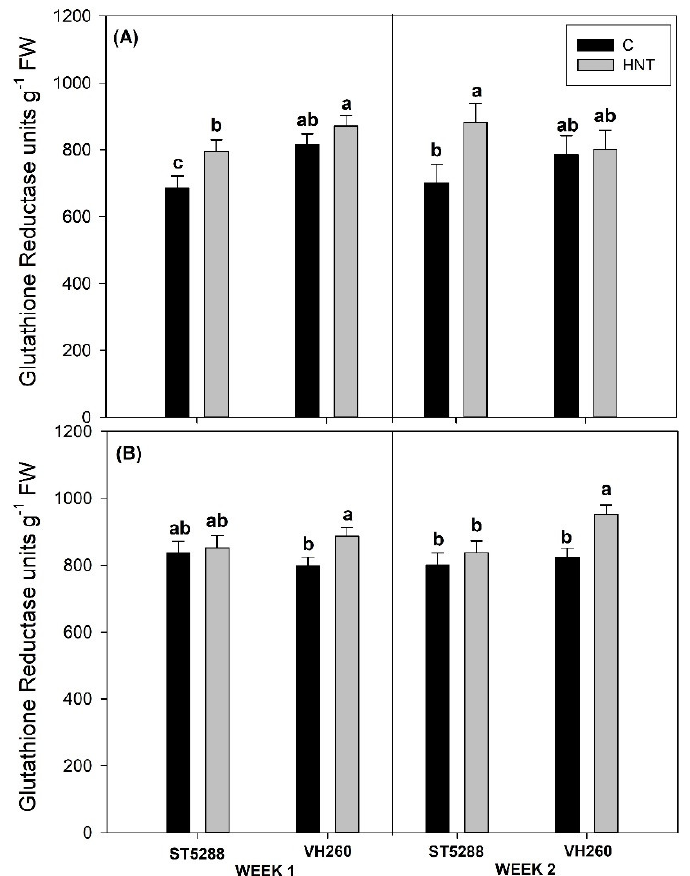
Figure 3. Effect of high night temperatures on subtending leaf glutathione reductase (GR) levels ( A ) and pistil GR levels ( B ) at the end of the first and second week after initiation of the treatment. Columns connected with different letters are significantly different ( p = 0.05). Error bars represent ±1 standard error. (C: control temperatures 32/24 °C, HNT: high night temperatures 32/30 °C).